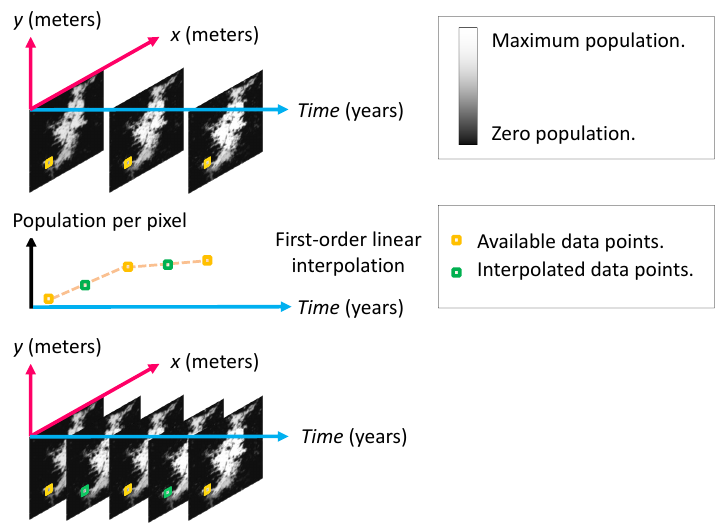
Figure 5. Temporal interpolation of the population